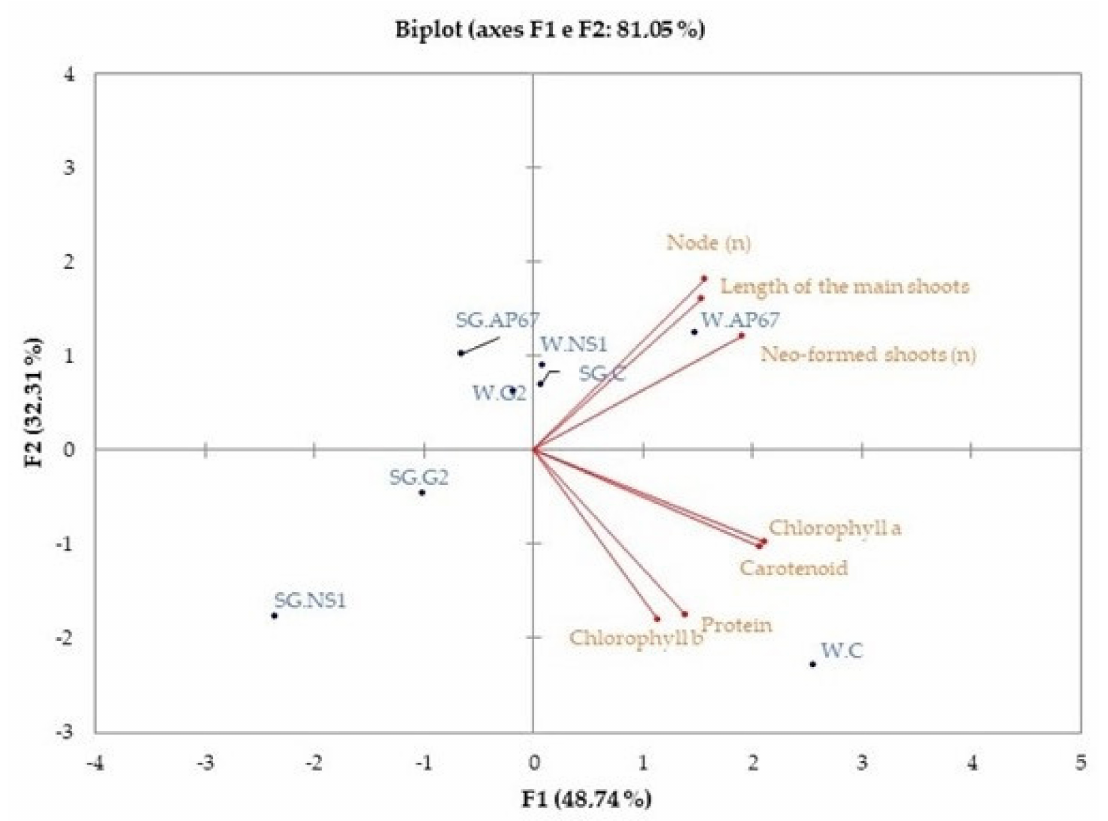
Figure 3. PCA representation of the factors levels on the plane spanned by the principal axes F1 and F2. Legend: SG.C = San Giovanni control; SG.AP67 = San Giovanni AP67; SG.G2 = San Giovanni G2; SG.NS1 = San Giovanni NS1; W.C = William control; W.AP67 = William AP67; W.G2 = William G2; W.NS1 = William